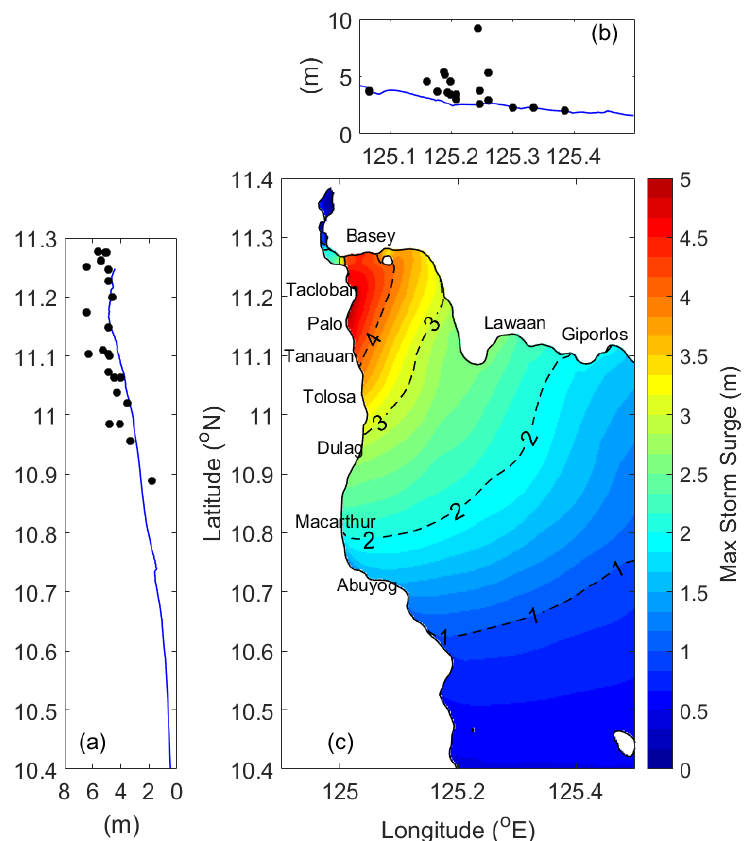
Figure 7. ( a , b ) Comparison between maximum computed storm surges and field survey data on along the coasts; ( c ) maximum computed storm surges driven by HWM. In Panels ( a , b ), the black dots imply the measured water level by field survey [33], and the blue lines indicate numerical results along the coasts. The y-axis of Panel ( a ) and the x-axis of Panel ( b ) correspond to the geographical coordinate of Panel ( c ). In Panel ( c ), the color shading indicates the maximum storm surge distribution in m, and solid black lines present the coastline. The dashed black lines show the contour of maximum computed storm surges. This figure has been zoomed in from its original computational domain.